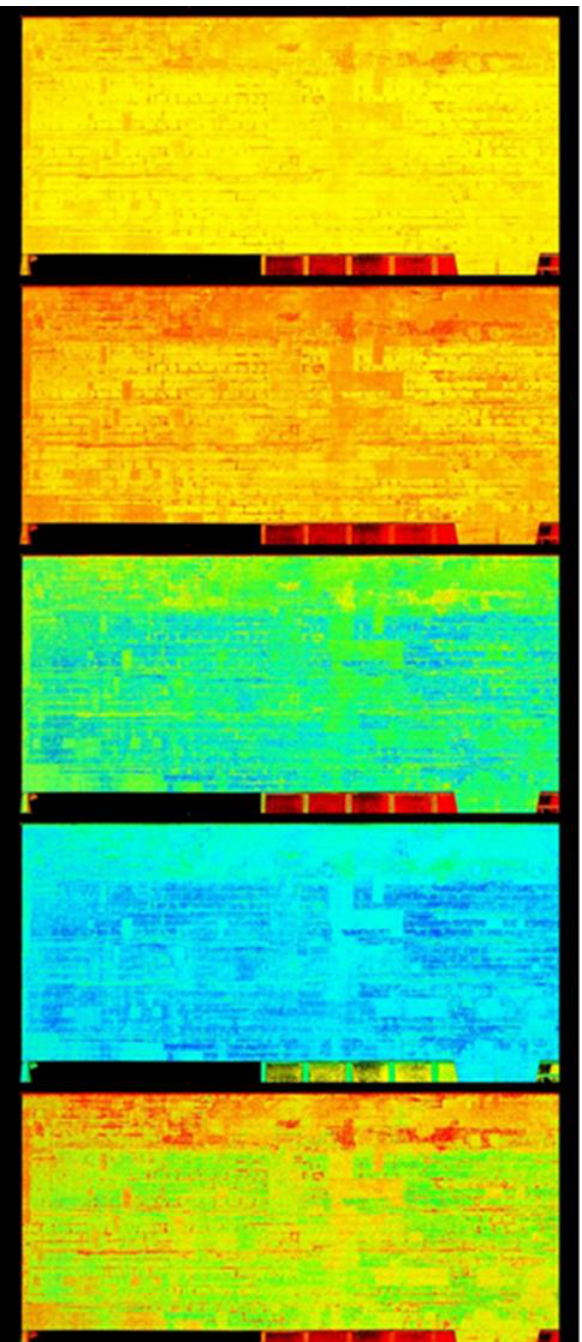
Figure 5. “False coloured” visualization of a sample are of the point cloud